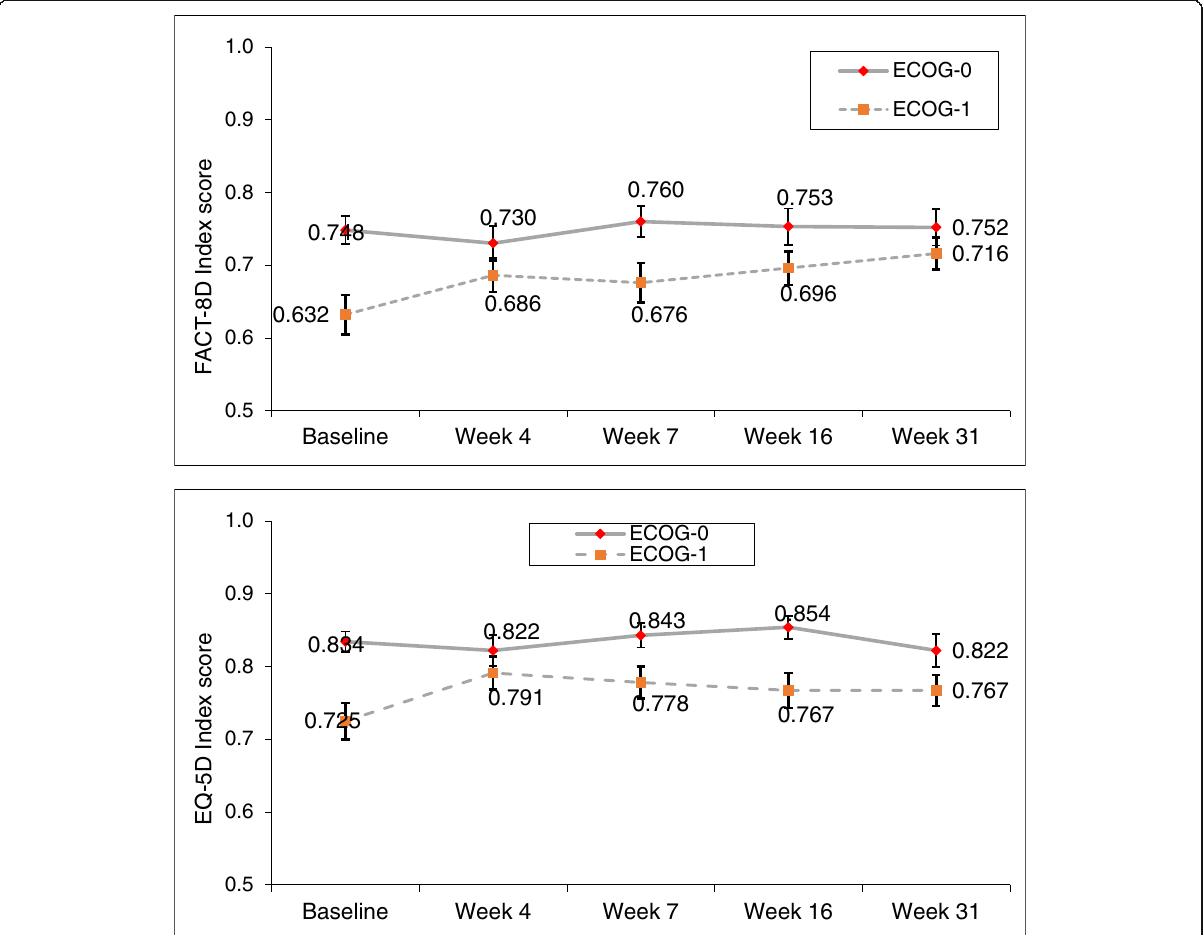
Fig. 3 Mean FACT-8D and EQ-5D-5L Crosswalk utility scores and standard errors by study visit for patients who completed the assessment at week 31 ( n = 76 for ECOG0, n = 54 for ECOG1), based on baseline ECOG